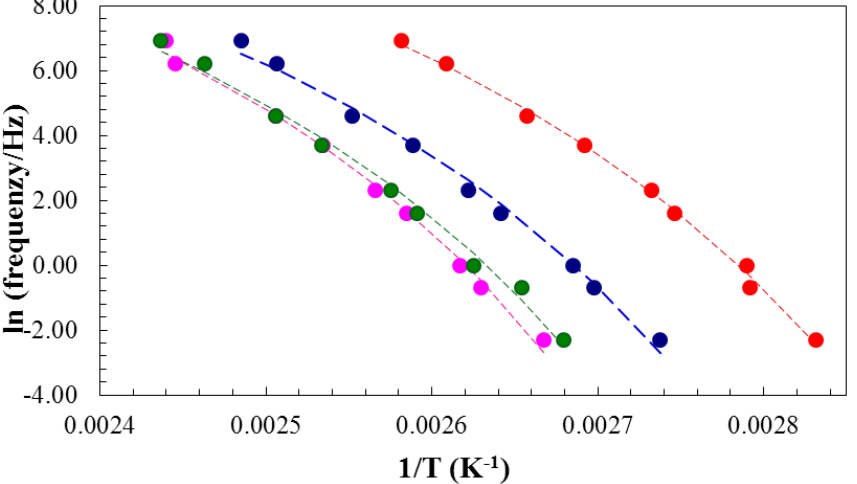
Figure 12. Ln(frequency/Hz) versus reciprocal glass transition temperature derived from the maximum in tan δ in scans at 2 °C/min for nanocomposite samples with different clay contents: 0 wt%, blue ; 2 wt%, pink; 5 wt%, green; 10 wt%, red. The dashed lines